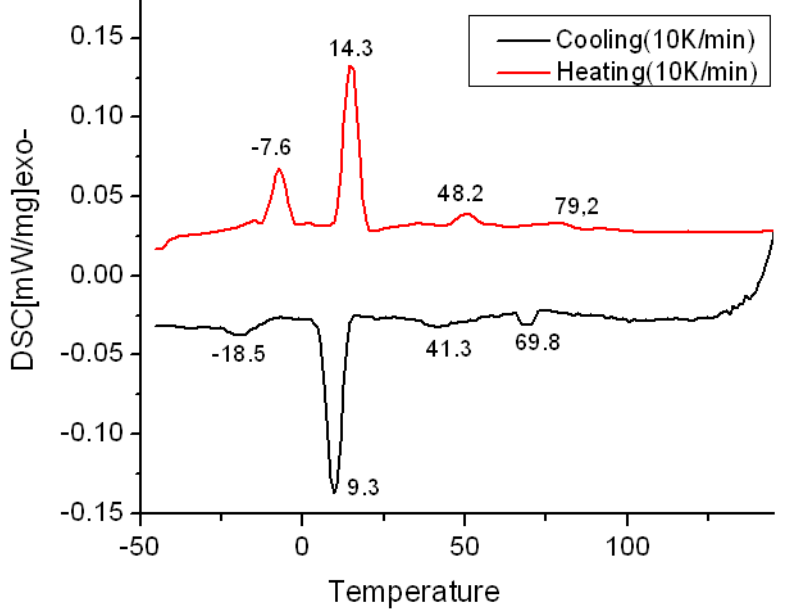
Figure 2. DSC traces during fi rst heating/cooling cycle of synthesized HBC.